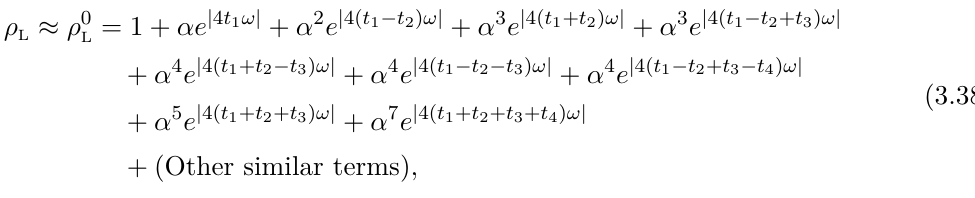
Figure 7 . log ρ and log ρ 0 vs time for the figure on the left. Relative error (log ρ 0 P P vs time for the figure on the right. The parameters are set as ωt s = − ωt f = 20 , δω/ω = 10 − 3